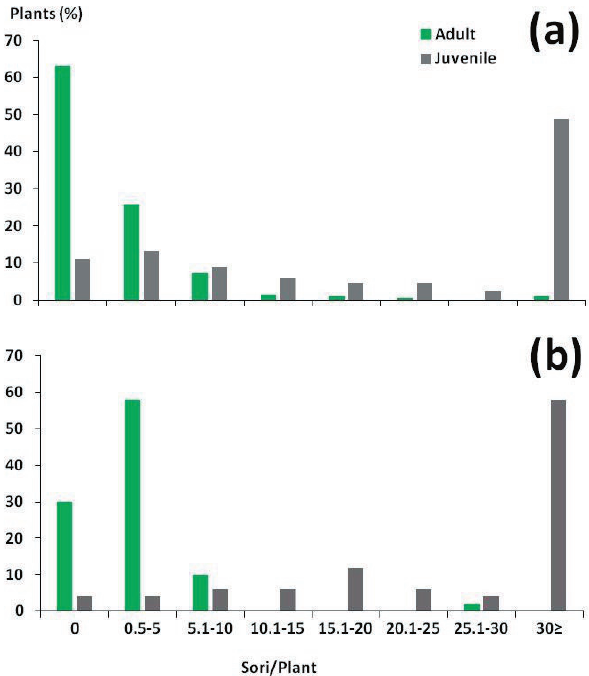
Figure 2. Distributions of average numbers of Albugo candida sori on Lunaria annua plants, in (a) 2017 and (b)